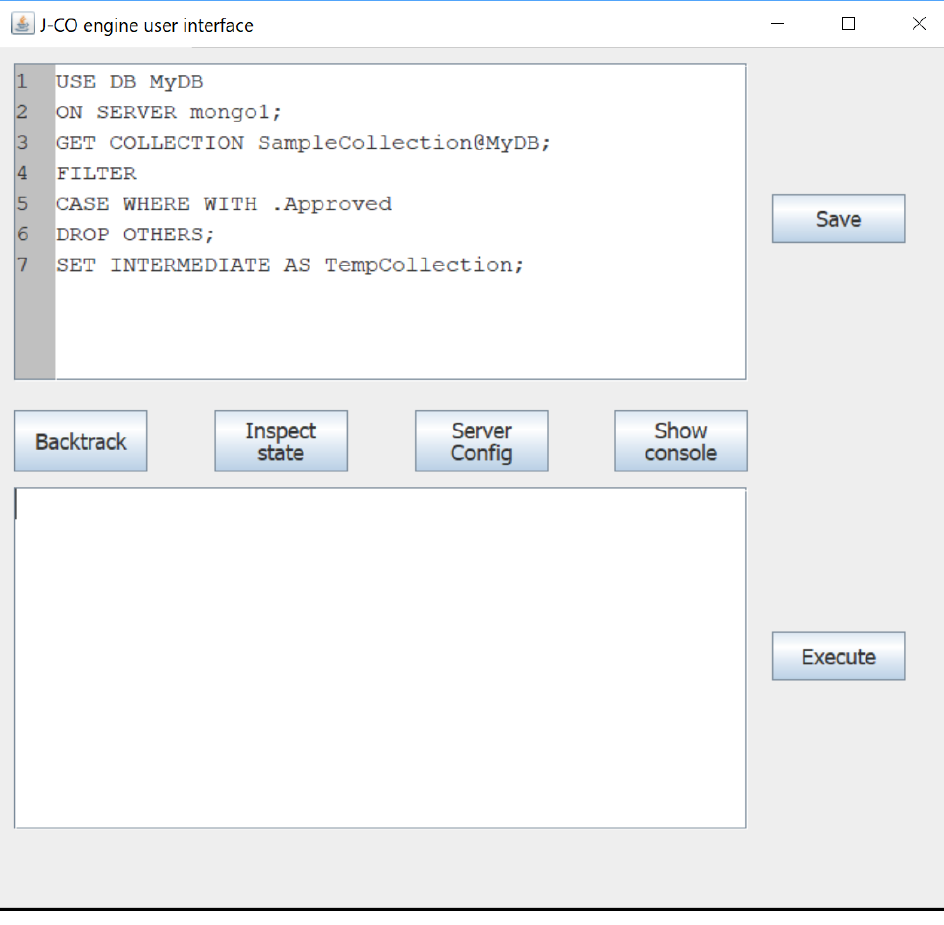
Figure 5. Main window of the J-CO-UI